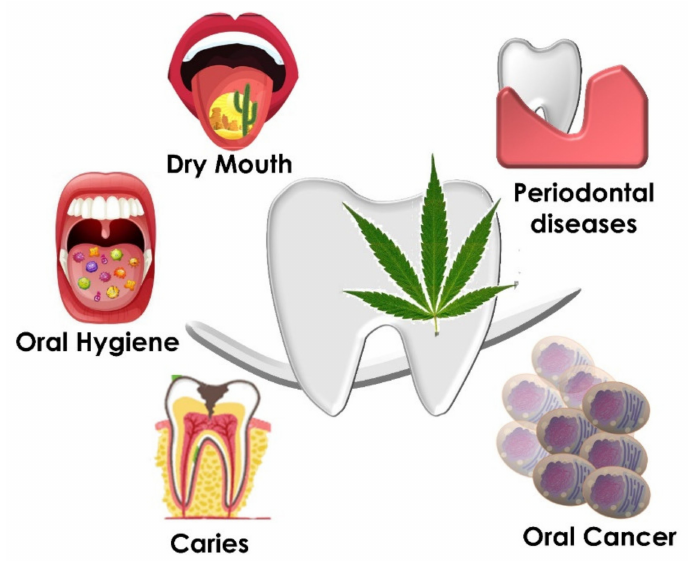
Figure 5. Oral pathologies and disease involved with cannabinoid exposure and